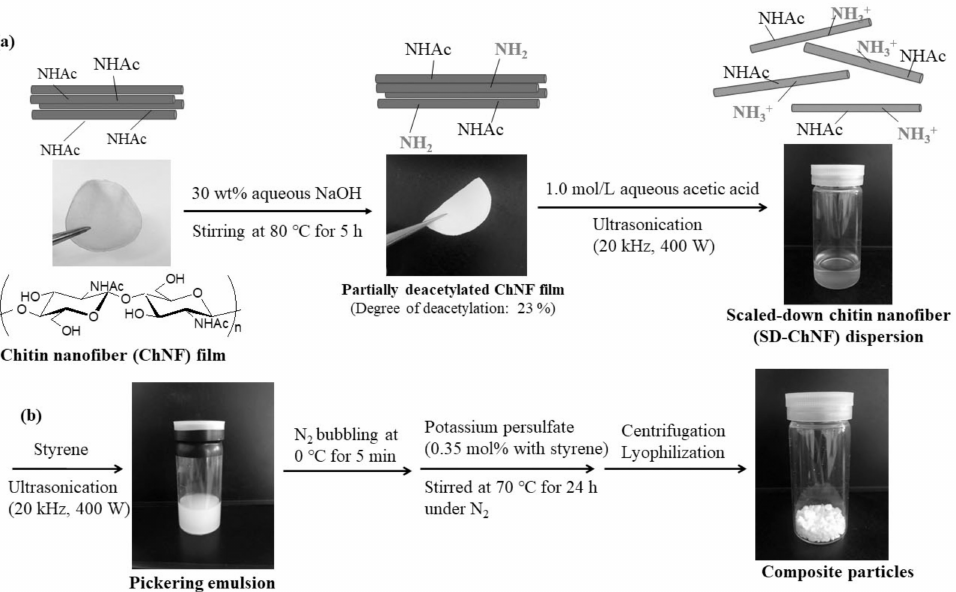
Figure 1. Procedures for the preparation of ( a ) a scaled-down chitin nanofiber (SD-ChNF) dispersion and ( b ) Pickering emulsion polymerization of styrene using SD-ChNFs as